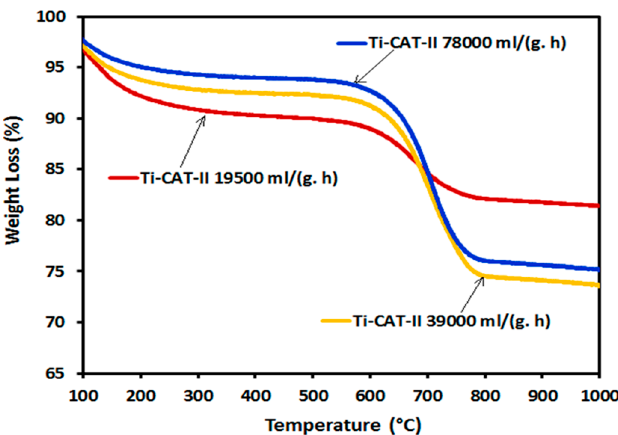
Figure 9. TGA curves for Ti-Cat-II at 19,500, 39,000 and 78,000 mL/(g · h) GHSV values.